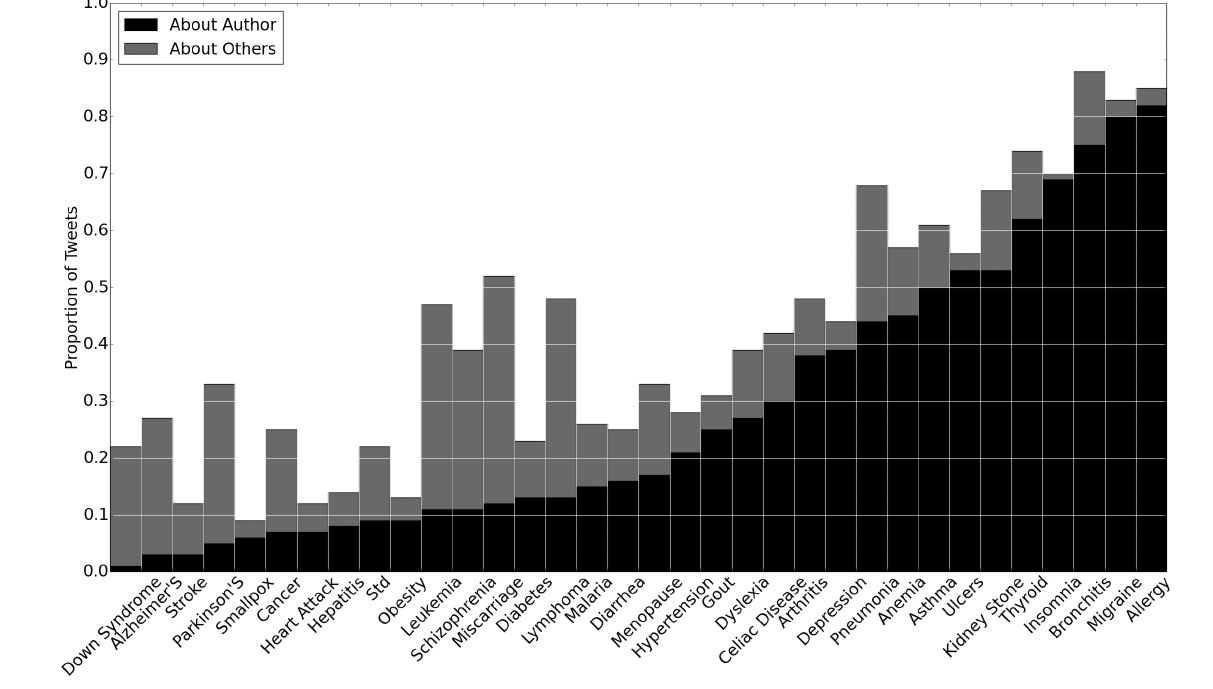
Figure 4. The extent to which people tweet about themselves versus others when disclosing personal health status. Note that this is a stacked bar chart, such that the sum of the author and others proportions corresponds to the overall proportion of positive